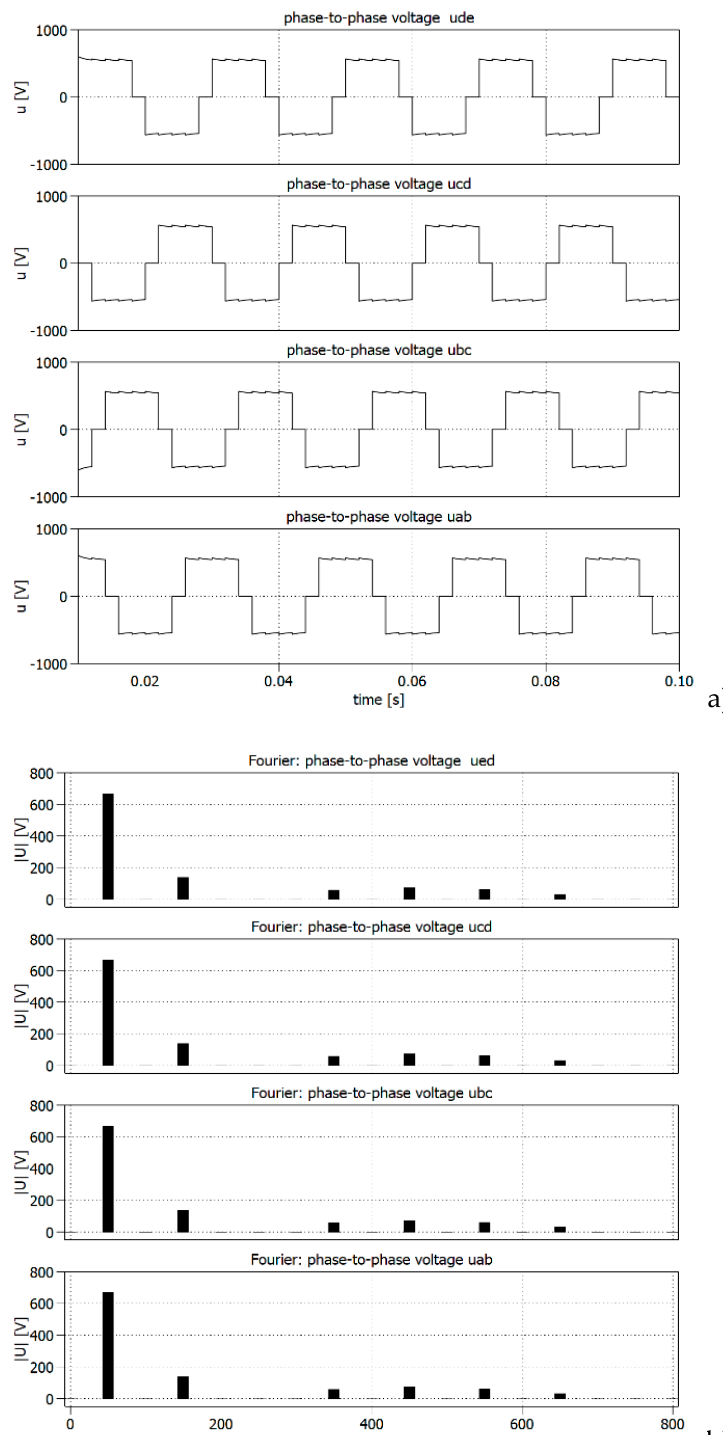
Figure 14. The phase-to-phase voltages: u ab , u bc , u cd , u de , where: ( a ) voltages waveforms and ( b ) voltages spectra.